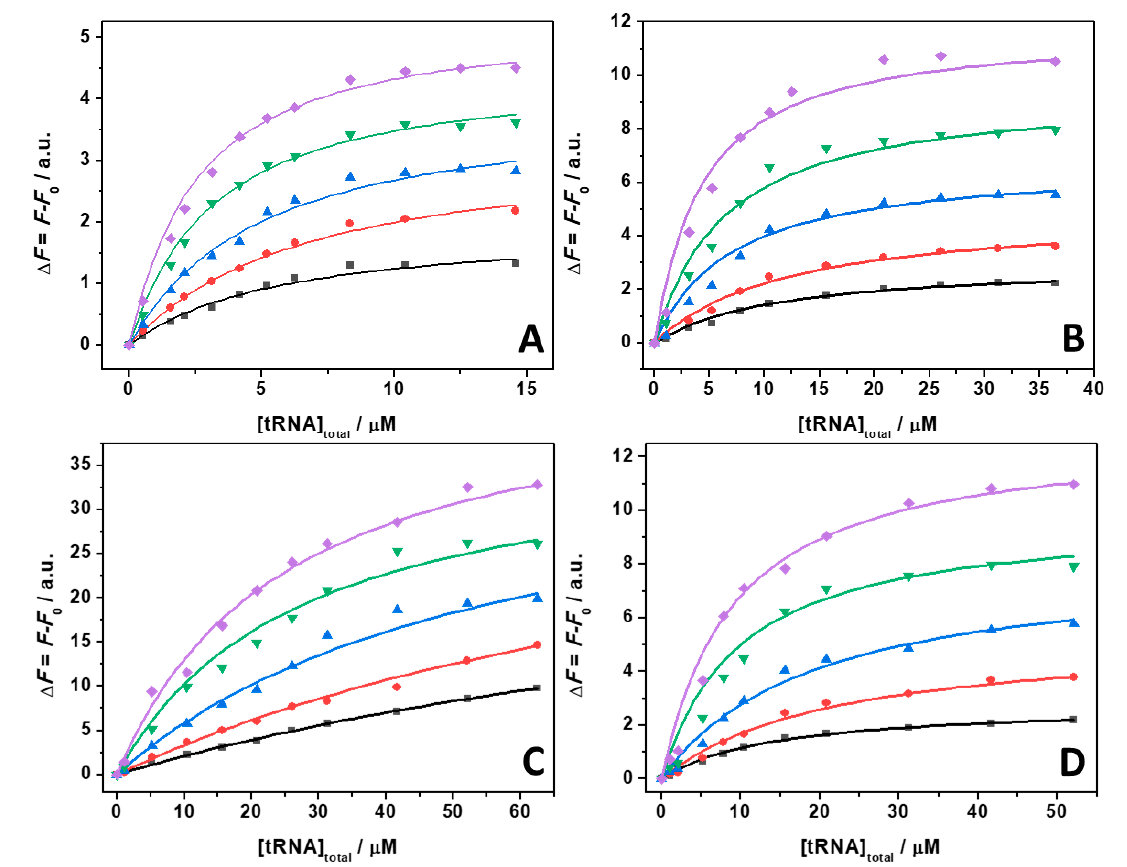
Figure 5. Binding isotherms for complex formation between tRNA and ThT obtained at the temperature of 25 °C in the absence ( A ) and in the presence of 1 mM of MgCl 2 ( B ), MgSO 4 ( C ), and Mg(ClO 4 ) 2 ( D ), at the following pressure values: 1 bar (black squares), 500 bar (red circles), 1000 bar (blue triangles), 1500 bar (green reversed triangles), and 2000 bar (magenta diamonds). The concentration of ThT was 0.5 µ M. The solid lines represent the best fit to the experimental data according to a 1:1 binding model. The binding isotherms were obtained by plotting Δ F = F-F 0 vs. total concentration of tRNA. Here, F and F 0 are the ThT fluorescence intensities in the presence and in the absence of tRNA, respectively. All the experiments were performed in 20 mM Tris-HCl buffer, pH 6.9. Table 2. Binding constants, K b , for tRNA–ThT complex formation in 20 mM Tris-HCl buffer, 40 mM KCl, pH 6.9, in the absence and in the presence of the indicated salts at the temperature of 25 °C and at the indicated pressures. Solution